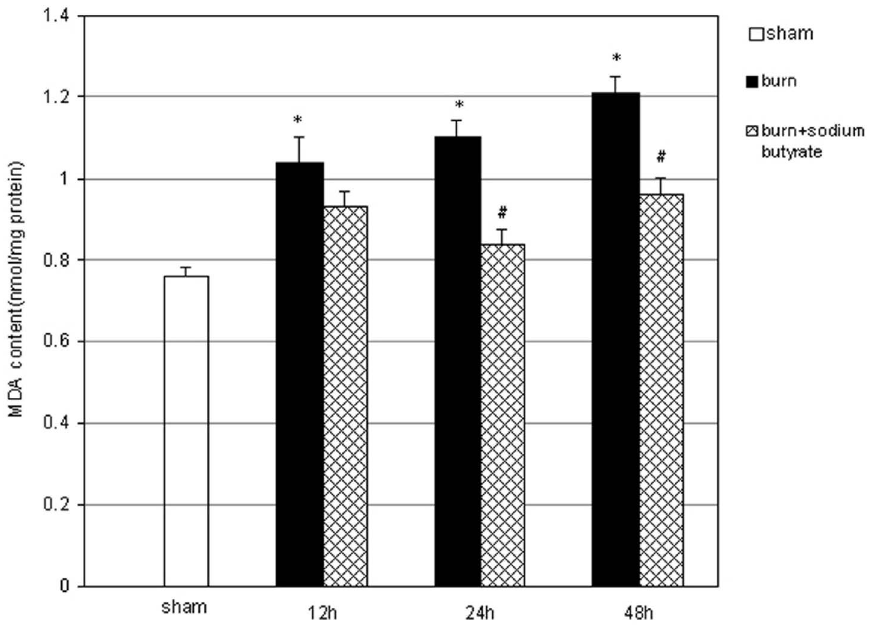
Figure 7. Effect of sodium butyrate on the MDA concentration in lung tissues. Pulmonary MDA concentration started to increase gradually at 12 h after burn injury, which was markedly attenuated by sodium butyrate treatment. Results are given as mean 6 SEM (n=8). *p , 0.05, vs. sham, ANOVA; # p , 0.05, vs. related burn group, ANOVA.